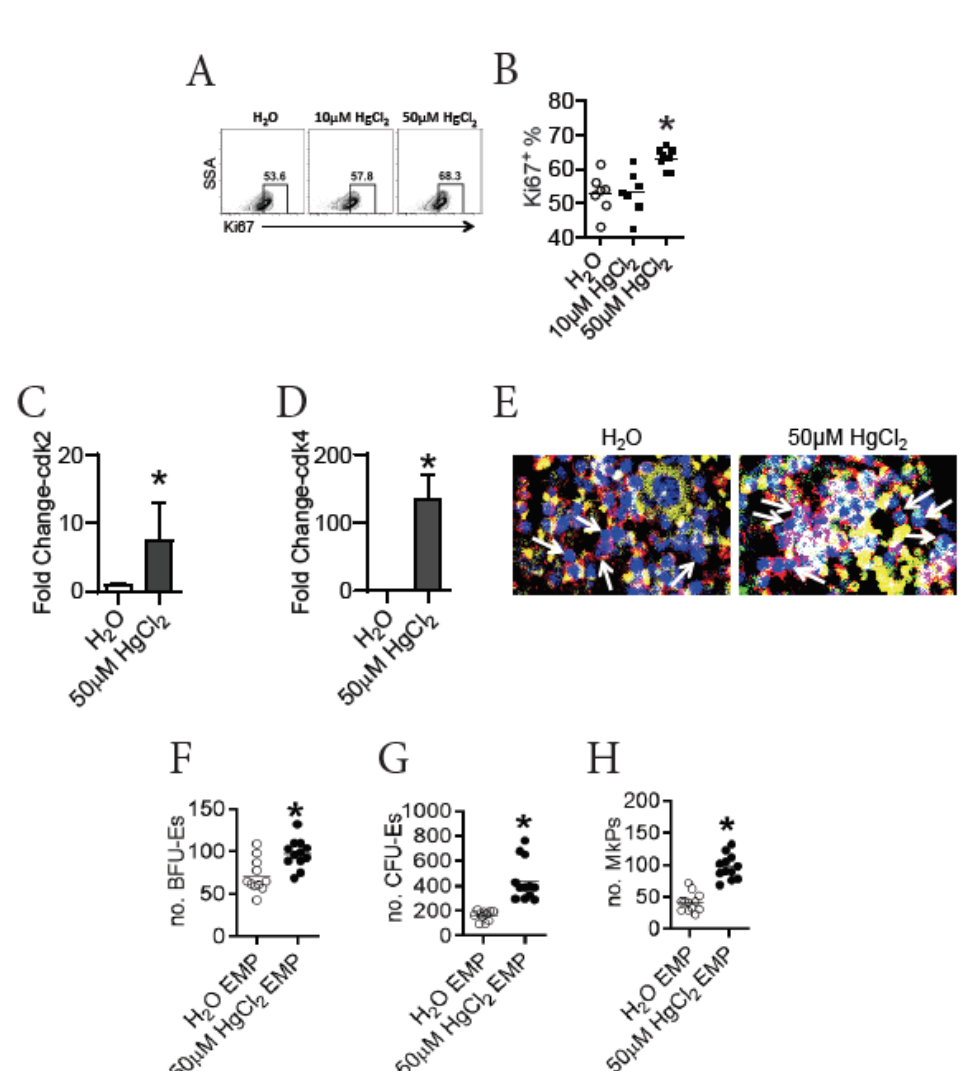
Figure 3. HgCl 2 increases the proliferation and differentiation of EMPs in the BM of B10.S mice. B10.S mice were treated with 10 µ M or 50 µ M HgCl 2 via drinking water for 4 w, and the proliferation of EMPs in the BM were measured. EMPs were purified from the BM of B10.S mice treated with the control or 50 µ M HgCl 2 through FACS sorting, and the EMPs were measured for the expression of cdk2 and cdk4 mRNA thereafter; the EMPs were also cultured in vitro for 16 h to evaluate their potential for differentiation into BFU-Es, CFU-Es, and MkPs. ( A ) Representative flow plots for the expression of Ki67 in EMPs in the BM. ( B ) Quantification of the expression of Ki67 in the EMPs as indicated in ( A ). ( C ) The expression of cdk2 mRNA (fold change) in EMPs in the BM. ( D ) The expression of cdk4 mRNA (fold change) in EMPs in the BM. ( E ) Representative confocal images for the proliferation (Ki67 + ) of erythrocyte progenitors as indicated by Lin - EPOR + DAPI + cells in the BM of B10.S mice treated with 50 µ M HgCl 2 or the control (yellow for Lin, red for EPOR, green for Ki67, and blue for DAPI). ( F ) The number of BFU-Es in the differentiation assay. ( G ) The number of CFU-Es in the differentiation assay. ( H ) The number of MkPs in the differentiation assay. Each dot represents one mouse or one sample, and a total of 7 to 12 mice or samples were used for each group. Asterisk indicates a significant difference compared to the counterpart control group. p < 0.05 was considered as the level of significant difference. 3.6. HgCl 2 Activates the Jak2/STAT5 Signaling Pathway to Promote EMP Differentiation in the BM of B10.S Mice